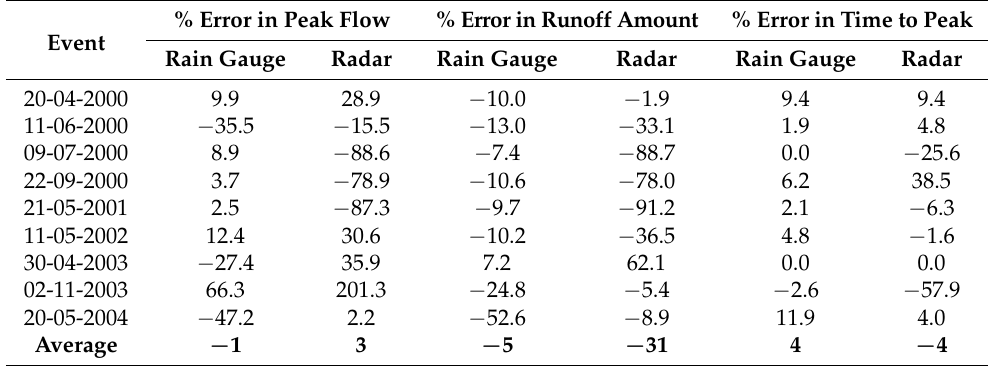
Table 9. Statistical comparison between observed and simulated peak flow rate, runoff amount, and time to peak using calibrated Green and Ampt model parameters.